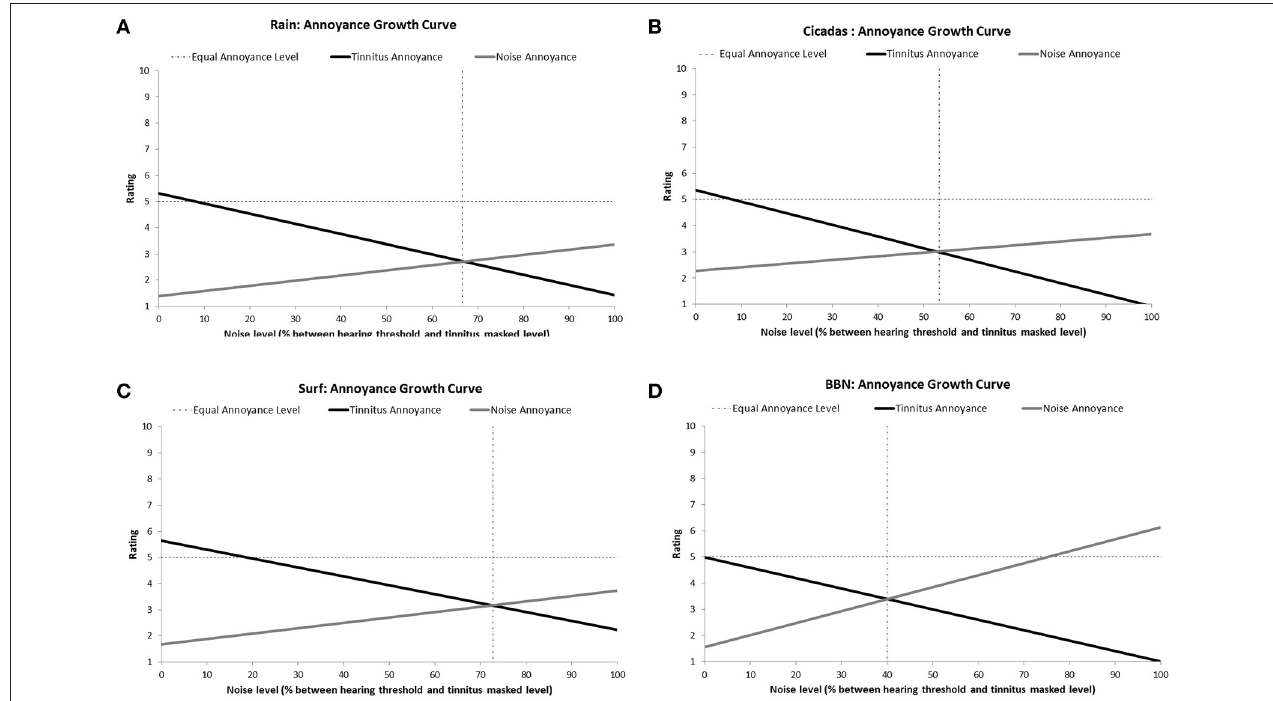
FIGURE 4 | Annoyance ratings growth curves of each therapy sound [Rain (A) , Cicadas on Farm (B) , Surf (C) , BBN (D) ] as a function of noise level (% between hearing threshold and minimum masking level for tinnitus]. Annoyance functions show decreases in tinnitus annoyance (solid black line) and increases in sound annoyance (solid gray line) as a function of sound level. The equal annoyance point (vertical dashed line) defines the sound level at which both tinnitus and sounds were of equal perceived annoyance (point of intersection between tinnitus annoyance and sound annoyance functions).